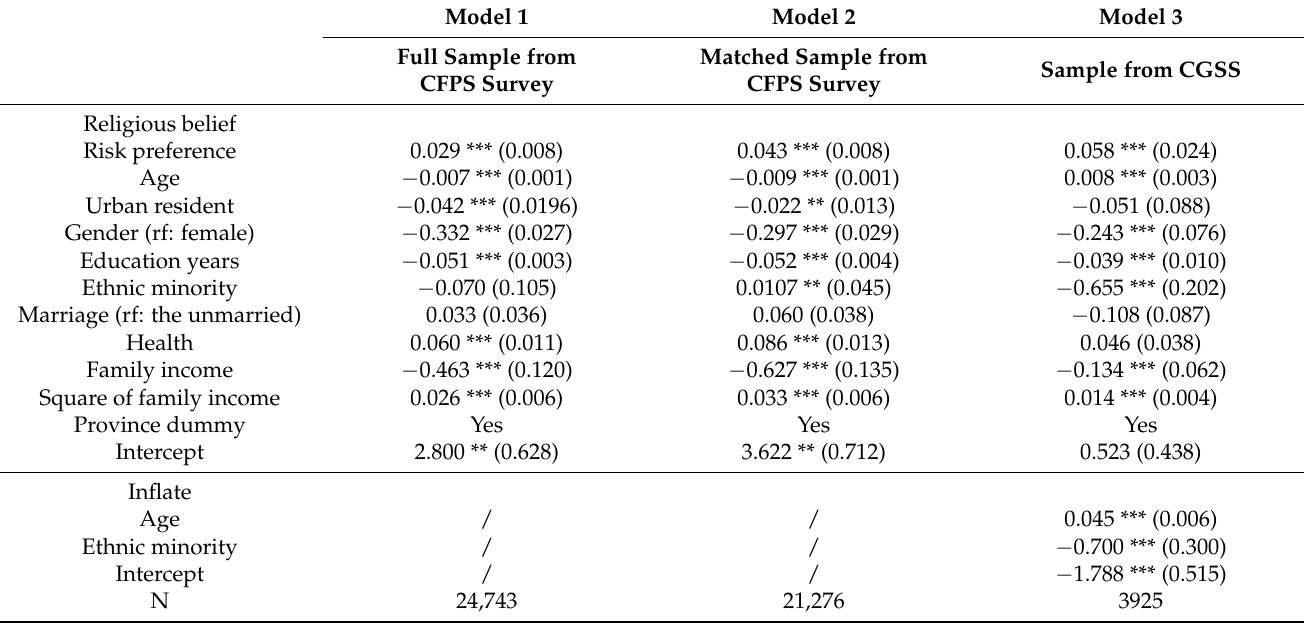
Table 2. Regressions for effects of risk preference on the probability of having a religious